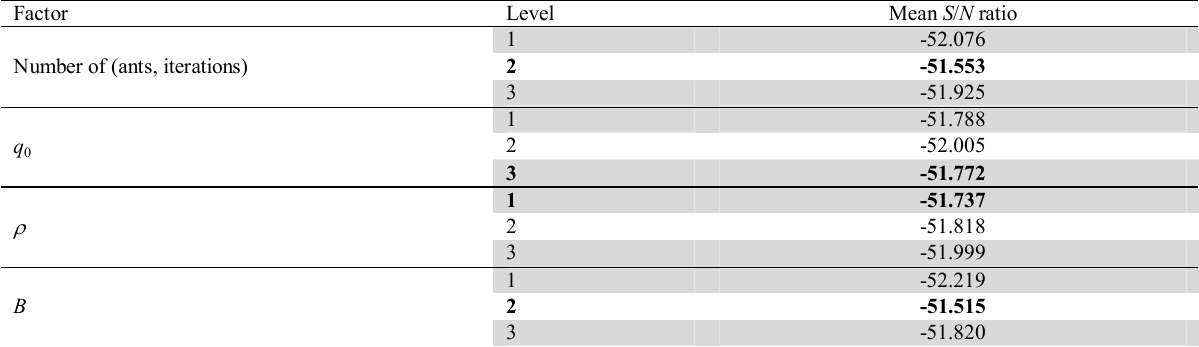
Results of the Taguchi method